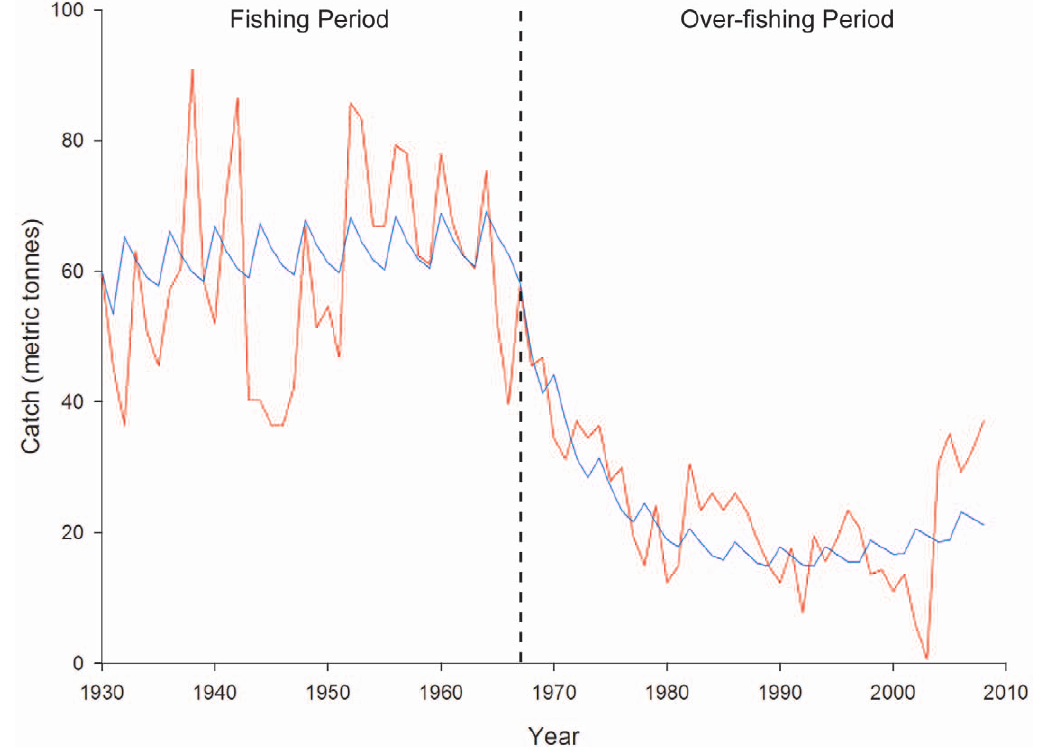
Figure 5. Lobster catch for Islas Robinson Crusoe and Santa Clara. Estimated proportion of Chilean lobster ( Jasus frontalis ) fishery catch from Islas Robinson Crusoe and Santa Clara (red line) with predicted catch from bioeconomic fishery model (blue line) for the ‘‘Fishing Period’’ from 1930– 1967 and the ‘‘Over-fishing Period’’ from 1967–2008.